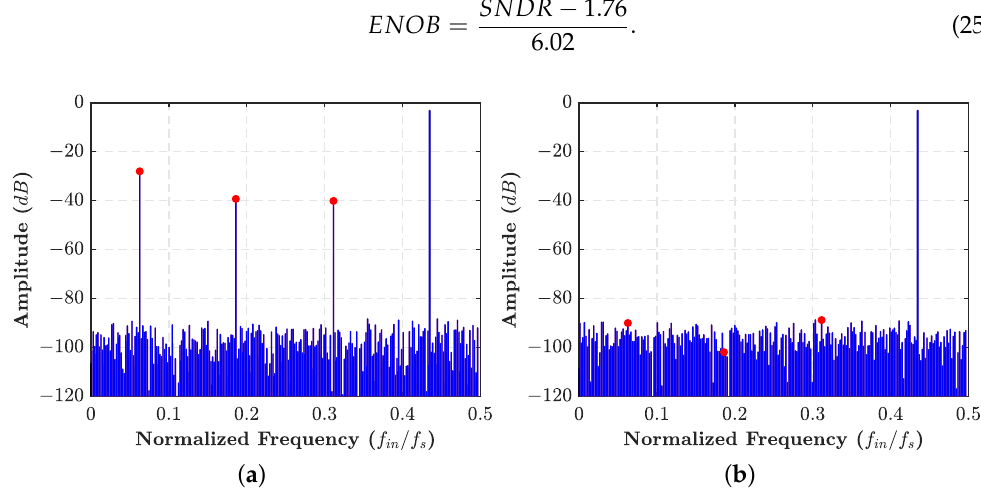
Figure 11. The frequency spectra of the TIADC output when f in / f s = 0.437: ( a ) before calibration (SNDR = 24.04 dB, SFDR = 24.57 dB); ( b ) after calibration (SNDR = 67.96 dB, SFDR = 85.69